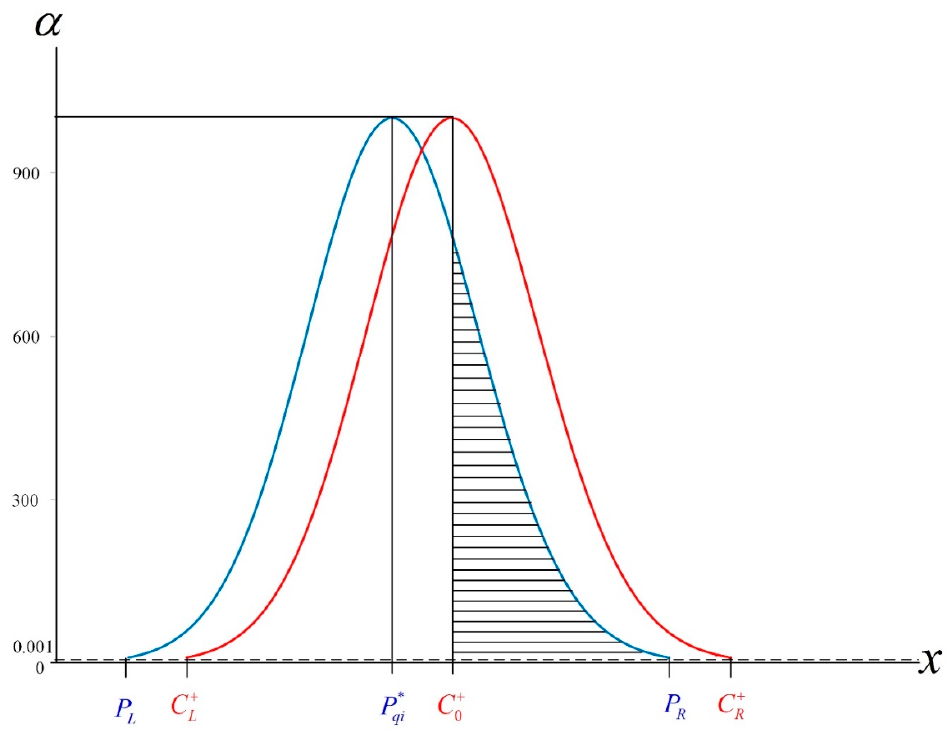
Figure 3. Membership functions η ( x ) and η + ( x )